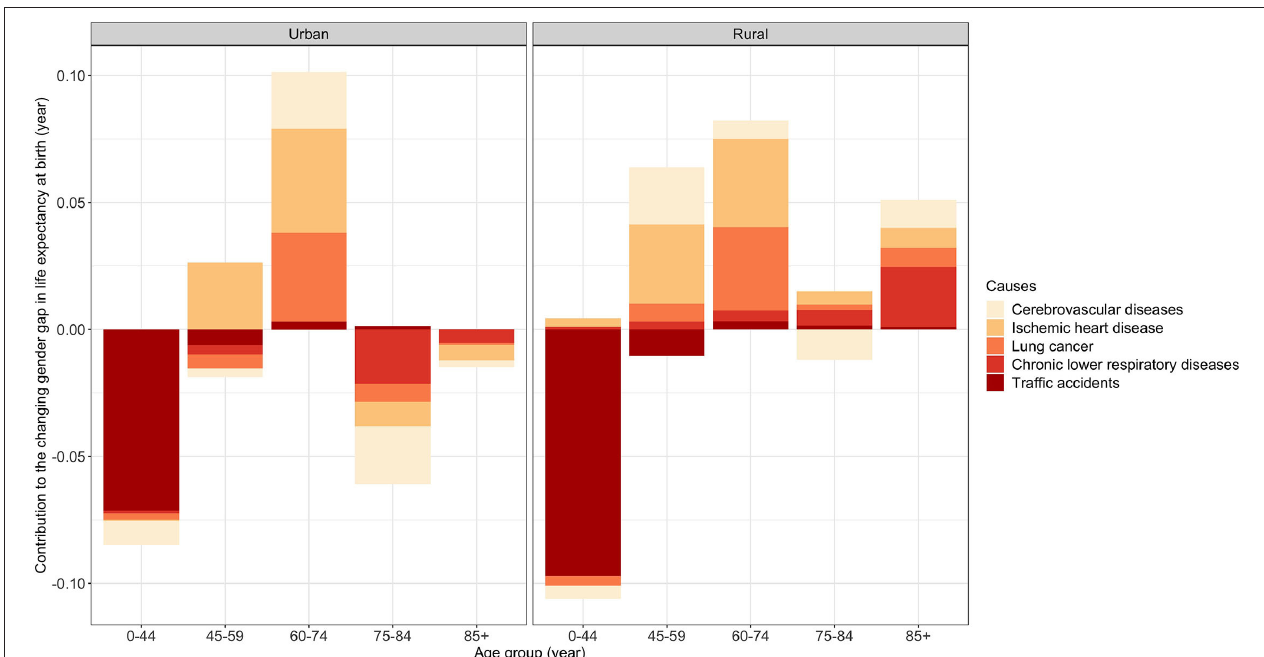
FIGURE 1 | Age- and cause-specific contributions to the changing gender gap in life expectancy at birth from 2013–2015 to 2016–2018 by urban-rural